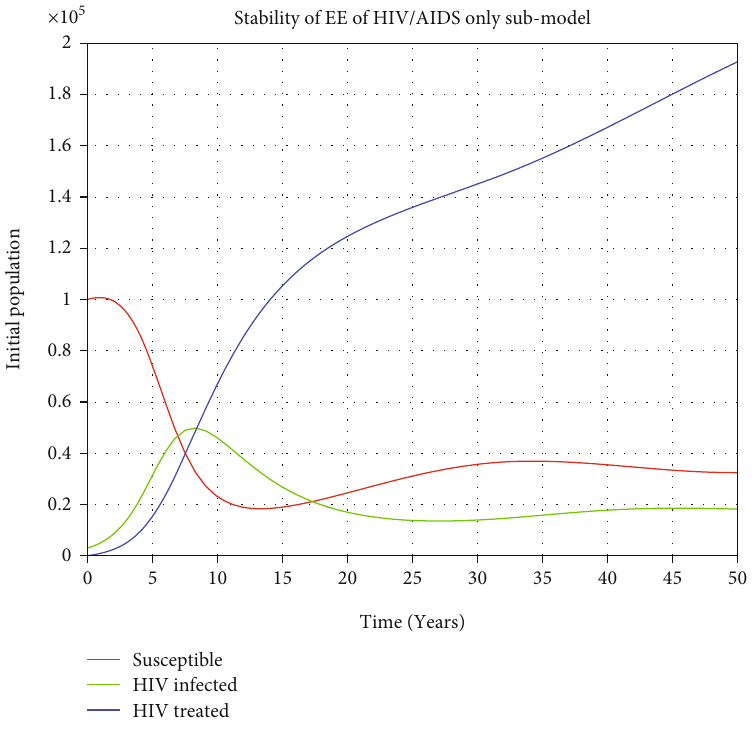
= 3 : 5 , ω = 0 : 9 , and δ = 0 : 01 H H 0